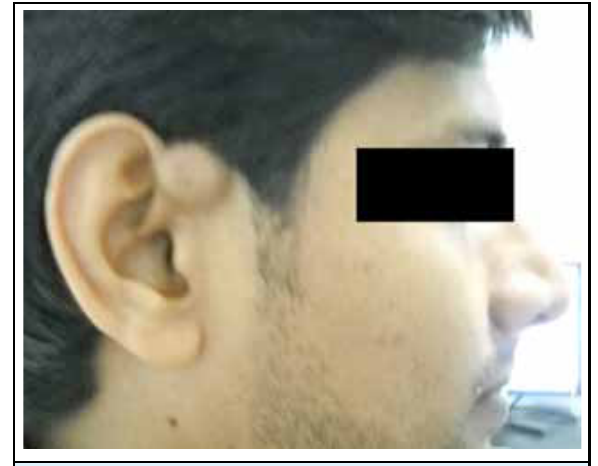
Figure 1. Single skin colored soft to firm nodule in front of right auricle.